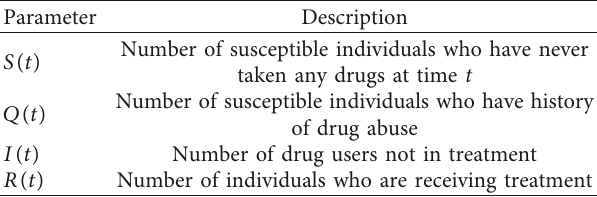
Table 1: The state variables for system (1).